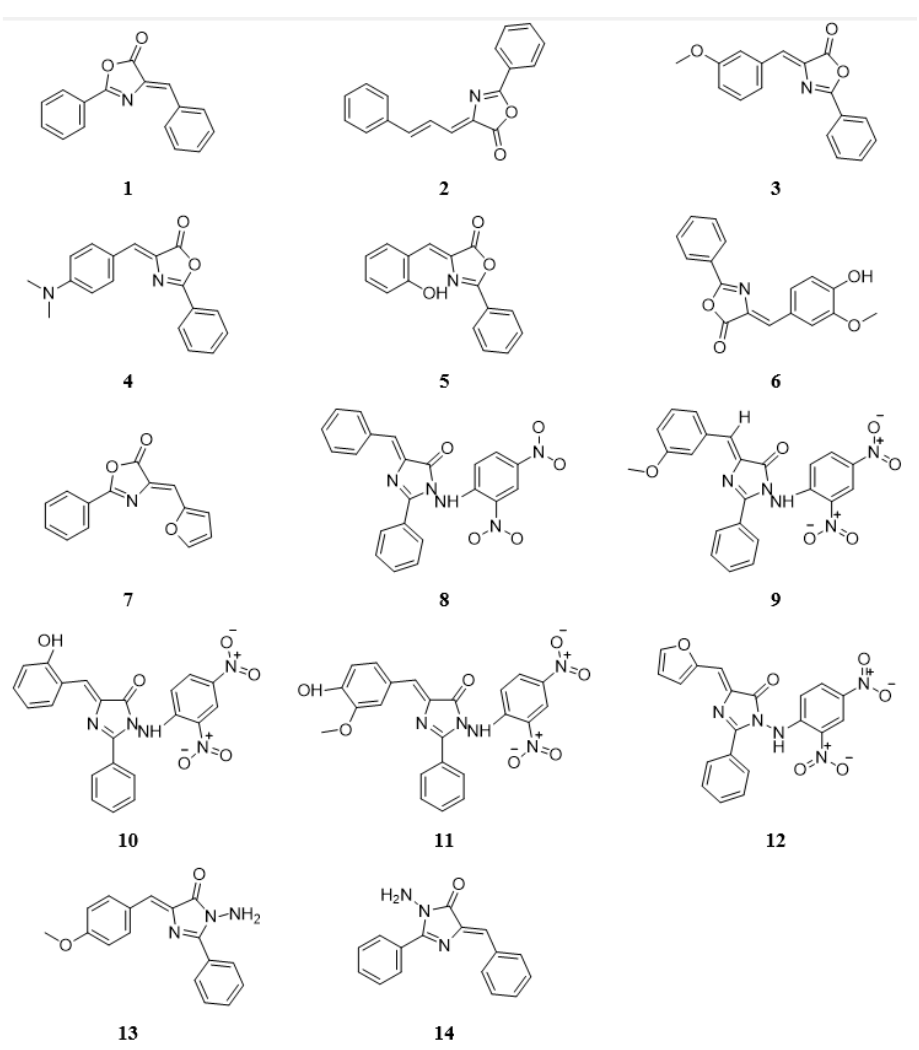
Figure 2. The chemical structures of nitrogen-based heterocyclic derivatives.